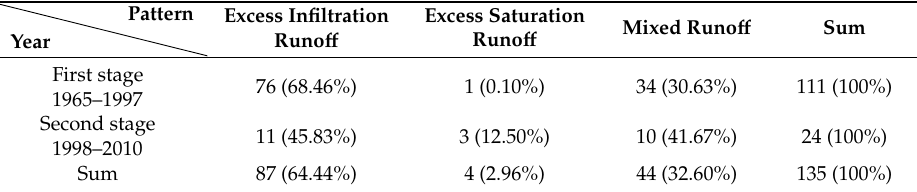
Table 8. Statistics of runoff generation patterns in different stages.